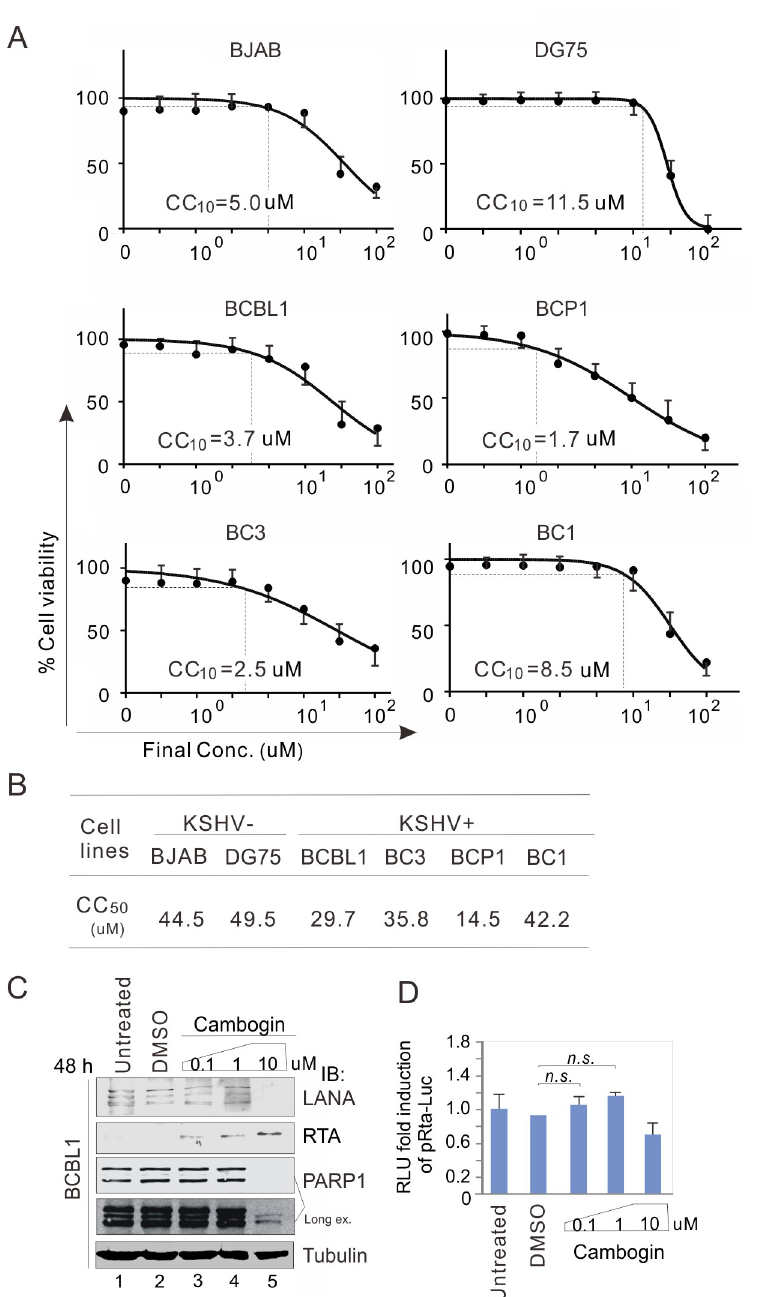
Fig 3. Cambogin presents higher cytotoxicity in PEL cells. ( A ) Cambogin induced relatively higher cytotoxicity in the KSHV-infected cells. The cell viability of KSHV positive and negative B-lymphoma cell lines treatment with different dosage of Cambogin treatment for 72 h. The concentration of Cambogin-induced 10% cell death (CC 10 ) was indicated. ( B ) The concentration of Cambogin-induced 50% cell death (CC 50 ) was calculated from panel A. ( C ) Cambogin moderately enhances the expression of RTA. BCBL1 cells were treated with DMSO or different concentrations of Cambogin for 48 h, followed by immunoblotting assays as indicated in the figure. Untreated was used as a control. ( D ) Reporter assays of the Rta promoter in the presence of Cambogin. HEK293T cells were transfected with the Rta promoter-driven Luciferase reporter (pRta-Luc). At 24 h post-transfection, cells were treated with DMSO or different concentrations of Cambogin for 24 h, and then harvest for reporter assays. The results were presented by the RLU (relative luciferase unit) fold compared with the untreated group. Data are presented as means ± SD of three independent experiments. n . s ., no